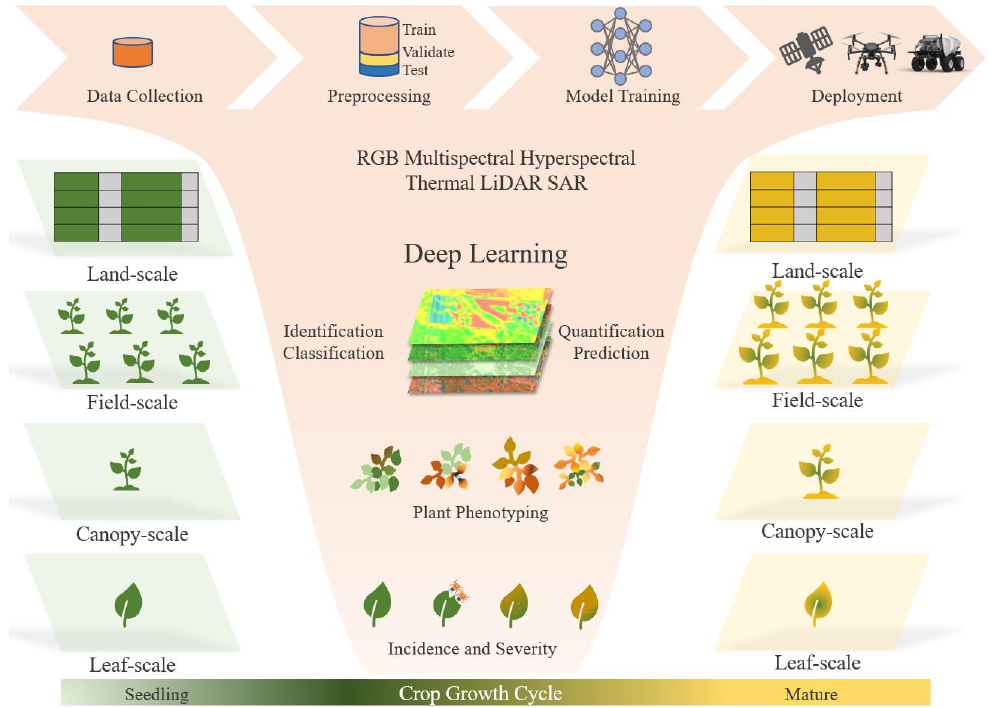
Figure 1. Deep learning in multiscale agricultural sensing.